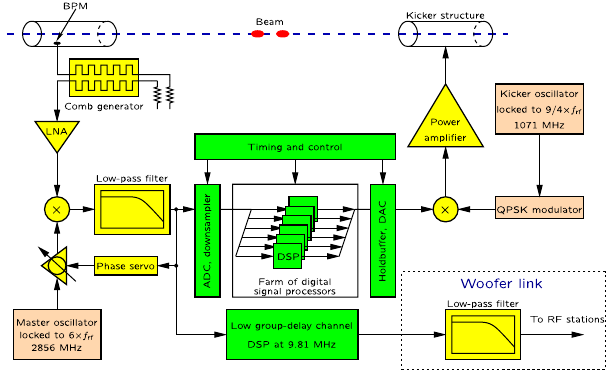
DC.FIG. 2. (Color) Block diagram of the longitudinal broadband feedback system developed for use at PEP-II/DAFNE/ALS. The system uses up to 500 MHz input and output sampling rates for a programmable DSP based array processor. In the PEP-II imple- mentation the beam signals are detected at 3 GHz, while the output signal is translated to a band centered at 1071